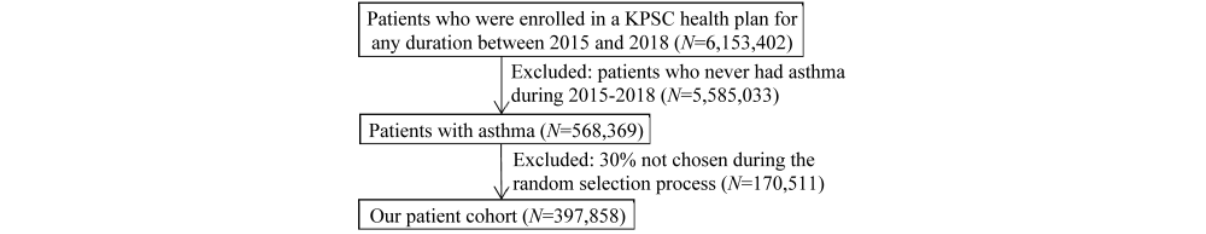
Figure 1. The patient cohort selection process. KPSC: Kaiser Permanente Southern